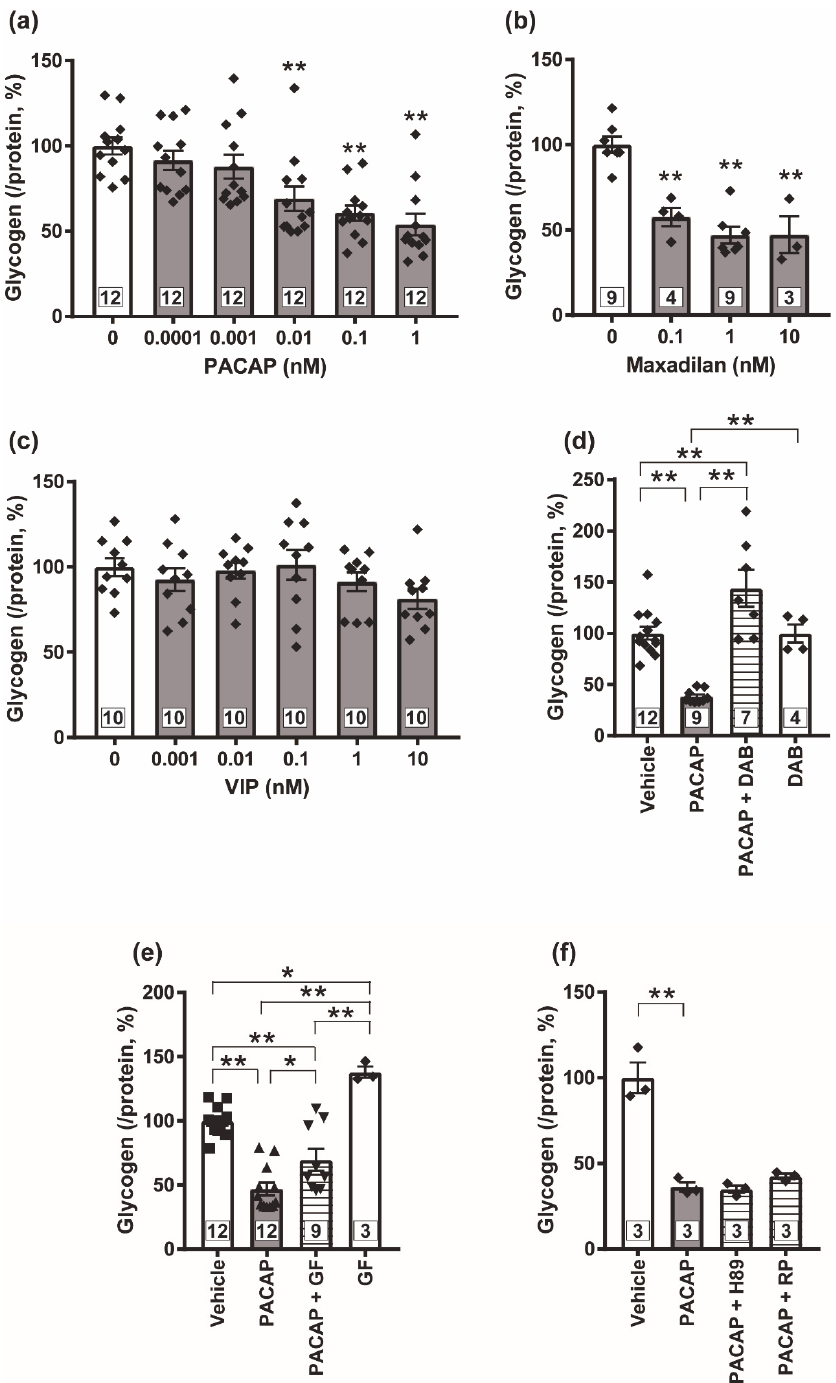
Figure 3. PACAP/PAC1 receptor/PKC signaling pathway induced glycogenolysis in cultured spinal cord astrocytes. Cultured astrocytes were exposed to PACAP (0.0001~1 nM) ( a ), Max (0.1~10 nM) ( b ) or VIP (0.001~10 nM) ( c ), and glycogen amounts contained in the astrocytes were measured 60 min after the exposure. Cultured astrocytes were pre-incubated with DAB (1 mM, ( d )), GF109203X (GF, 5 µ M, ( e )), H89 (10 µ M, ( f )), or Rp-8Br-cAMPS (RP, 100 µ M, ( f )) for 30 min prior to PACAP (1 nM) exposure, and glycogen amounts contained in the astrocytes were measured 60 min after the PACAP exposure. * p < 0.05 and ** p < 0.01 when compared with 0 nM (Vehicle) data in ( a – c ), and compared groups are indicated above in ( d – f ). Statistical significance was evaluated by the Dunnett test for ( a – c ), and Tukey test for ( d – f ). Exact sample sizes are indicated in the